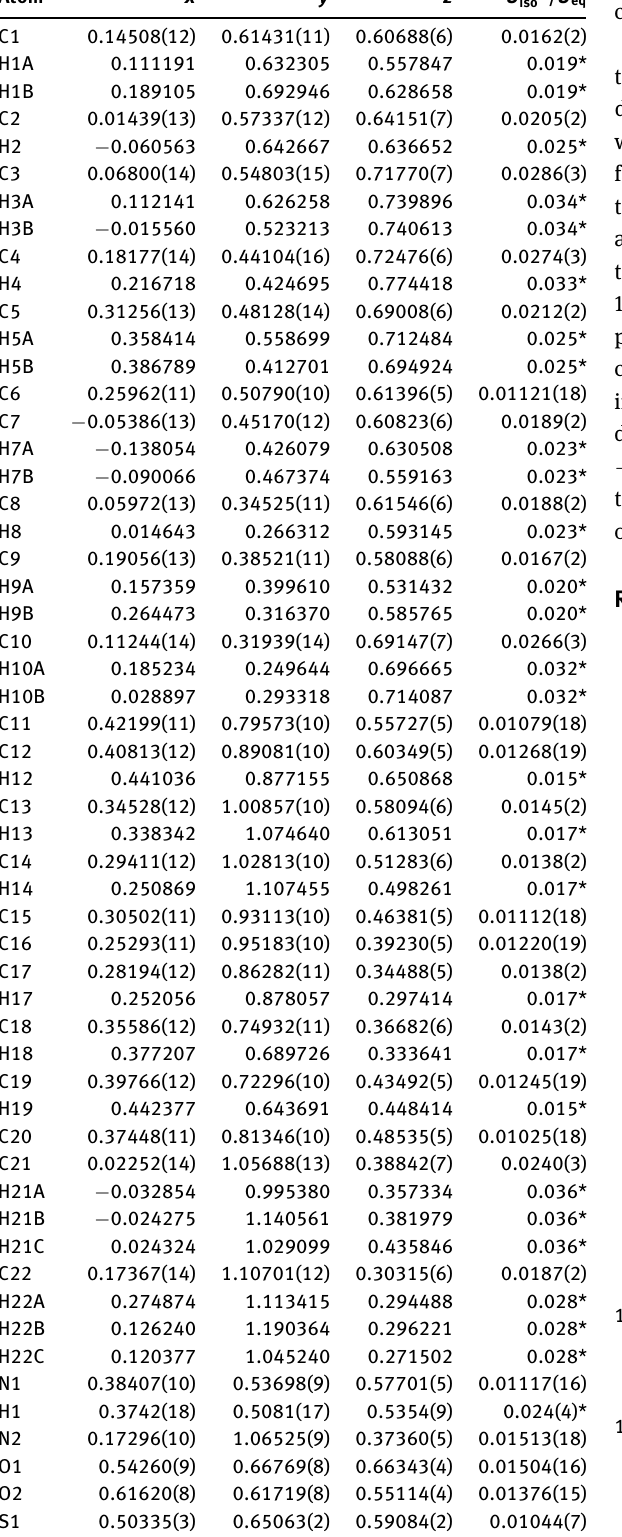
Table 2: Fractional atomic coordinates and isotropic or equivalent isotropic displacement parameters (Å 2